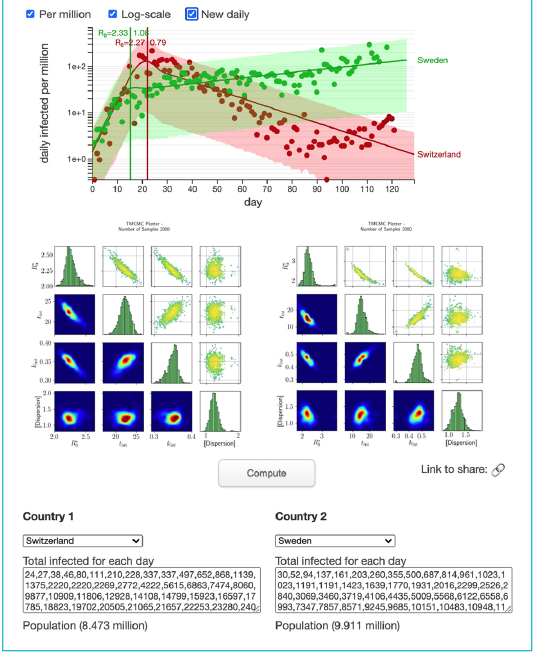
Figure 1: Screenshot of the online interface comparing predictions for Switzerland and Sweden on 2 July 2020 with 2000 samples https://cse-lab.ethz.ch/coronavirus.